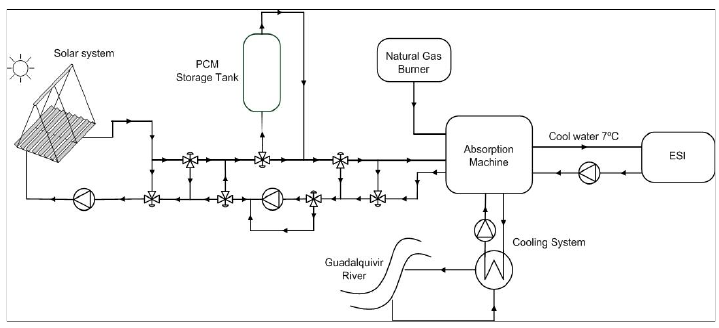
Figure 1. Plant general